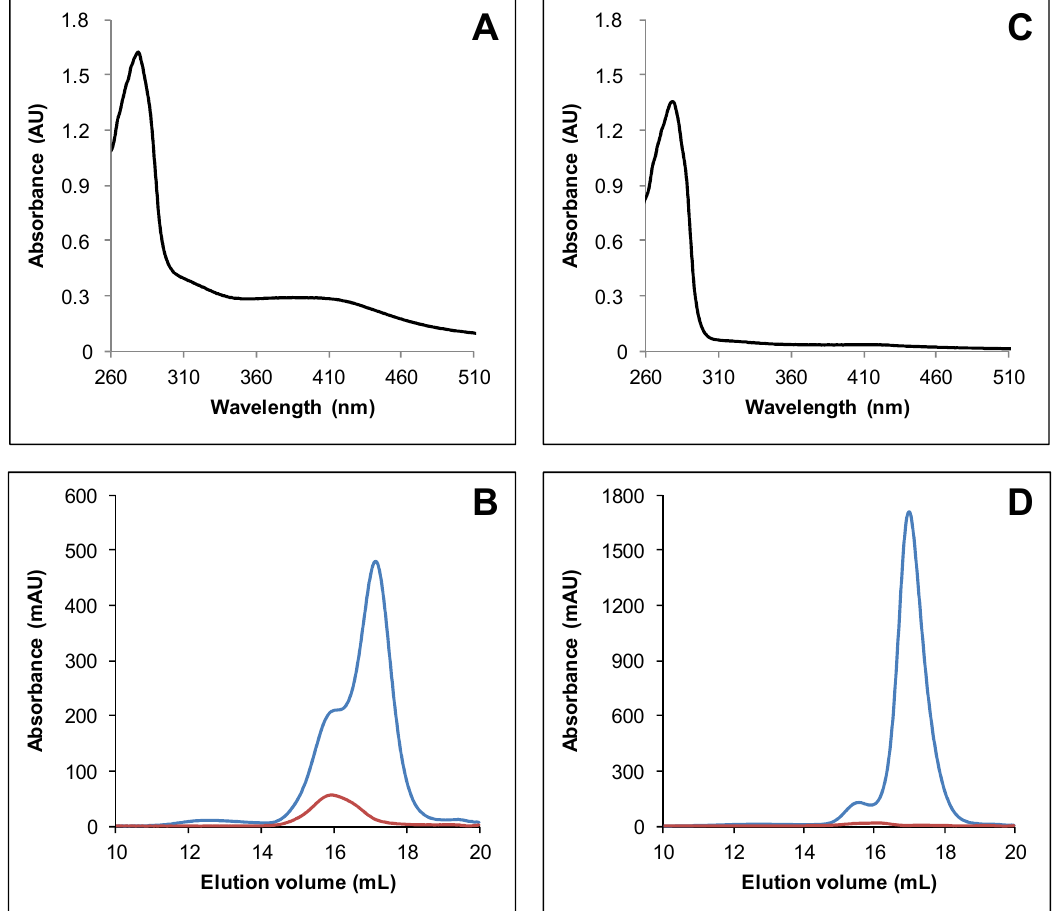
Figure 1. Arabidopsis TRXo (thioredoxin- o ) isoforms incorporate an Fe-S cluster after heterologous expression in E. coli . UV–visible absorption spectra of His-tagged recombinant TRXo2 ( A ) and TRXo1 ( C ). Spectra were recorded after an anaerobic purification in 30 mM Tris-HCl pH 8.0. Analytical gel filtration of His-tagged recombinant TRXo2 ( B ) and TRXo1 ( D ), purified in anaerobic conditions, was performed by loading 100 to 300 µg of protein onto a Superdex S200 10/300 column. The presence of the polypeptide and of the Fe-S cluster have been detected by the absorbance at 280 nm (blue line) and 420 nm (red line), respectively.